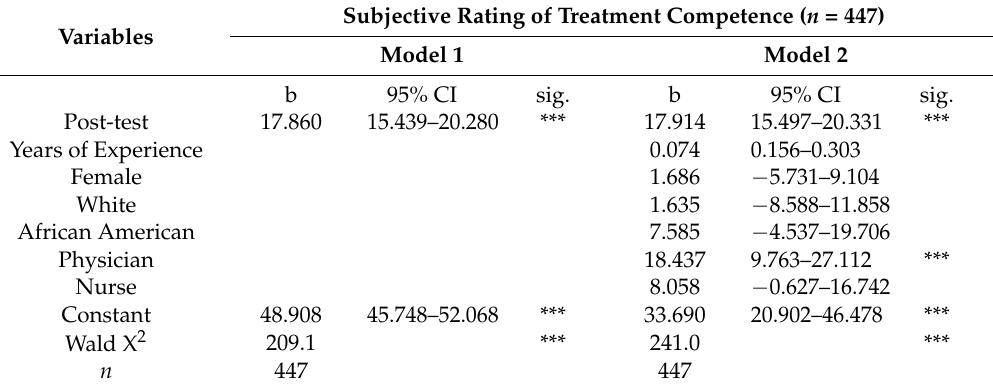
Table 4. Random Effects Regression Models for Treatment Competence